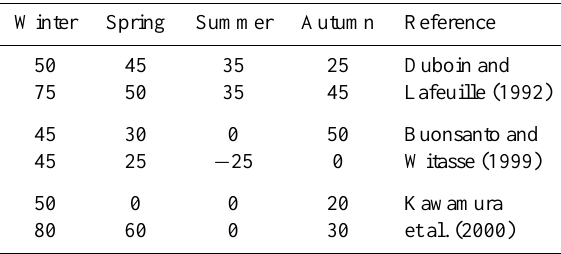
Table 2. Observed quiet time northward thermospheric wind veloc- ity (m/s) at noon under solar maximum (first line) and solar mini- mum (second line) conditions.